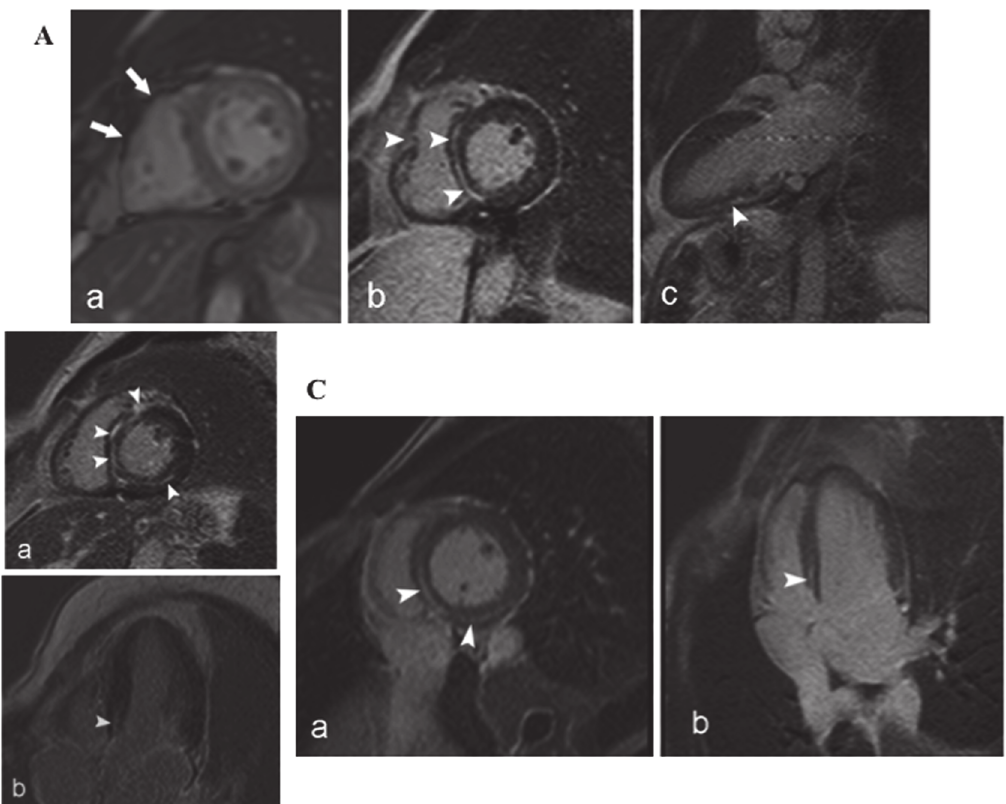
Fig 3. CMR imaging of LMNA mutation-positive family members. (A) Short-axis cine (a) and LGE sequences in the Short-axis (b) and 2-chambers long- axis views (c). Bulging (arrow in a) and LGE of the RV free wall (arrowheads in b). Linear midwall LGE is localized at the interventricular septum and LV inferior wall (arrowheads in c) (subject III-5). (B) and (C) LGE sequences in the short axis (a) and 4-chambers long axis views (b). LGE with linear midwall pattern is shown on the LV inferior wall and basal interventricular septum (arrowheads) (subjects III-8, and